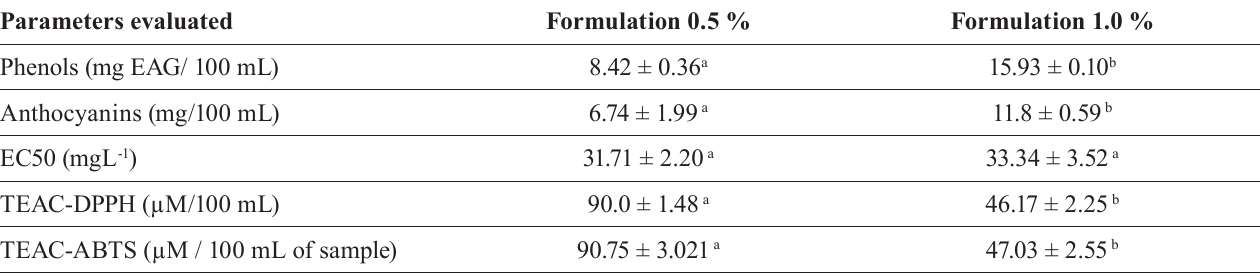
TABLE III - Total phenol and anthocyanin contents and antioxidant activity of the hydroelectrolytic beverage formulations devel ped in concentrations of 0.5 % and 1.0 % of bacaba peel extract Parameters